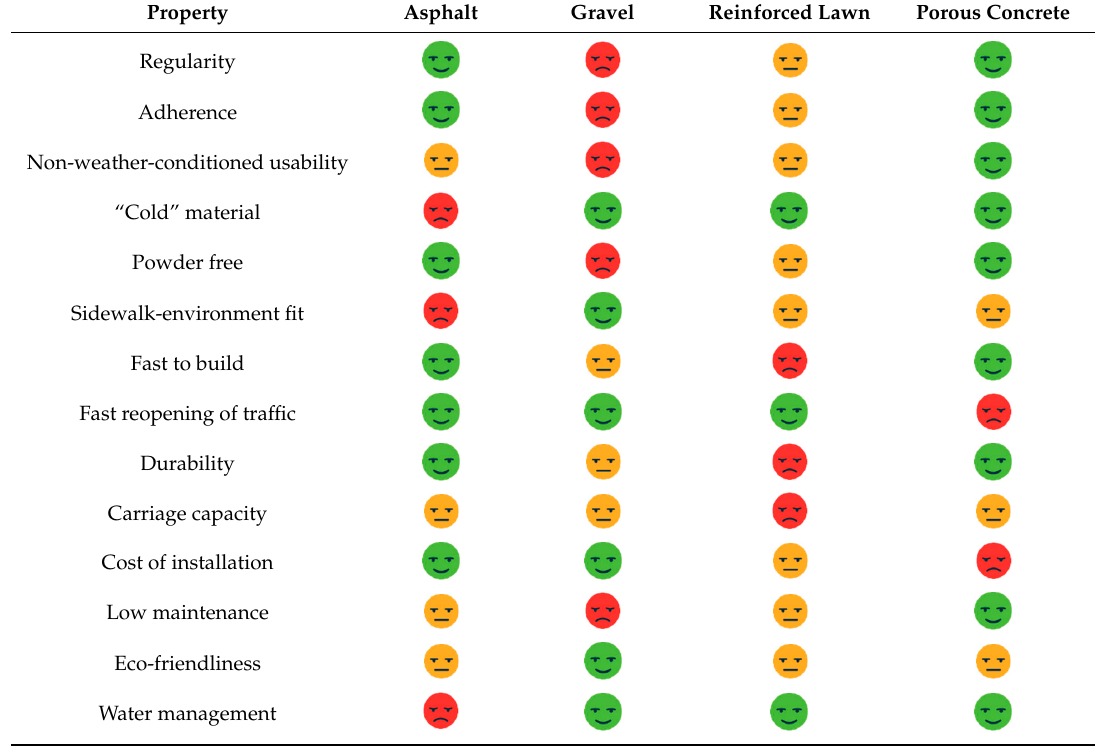
considered). with green, orange, and red symbols, respectively. All data refer to conventional performances of considered). Table 1. Structural, functional, and environmental performances of materials for pedestrian Table 1. Structural, functional, and environmental performances of materials for pedestrian Table 1. Structural, functional, and environmental performances of materials for pedestrian Table 1. Structural, functional, and environmental performances of materials for pedestrian each material (e.g., white asphalt, pervious concrete pavers, and concrete grid pavers are not with green, orange, and red symbols, respectively. All data refer to conventional performances of pavements. Green, orange, and red symbols represent good, fair, and poor performances, pavements. Green, orange, and red symbols represent good, fair, and poor performances, pavements. Green, orange, and red symbols represent good, fair, and poor performances, pavements. Green, orange, and red symbols represent good, fair, and poor performances, Table 1. Structural, functional, and environmental performances of materials for pedestrian pavements. considered). considered). Table 1. Structural, functional, and environmental performances of materials for pedestrian Table 1. Structural, functional, and environmental performances of materials for pedestrian Table 1. Structural, functional, and environmental performances of materials for pedestrian each material (e.g., white asphalt, pervious concrete pavers, and concrete grid pavers are not respectively. respectively. each material (e.g., white asphalt, pervious concrete pavers, and concrete grid pavers are not respectively. respectively. Table 1. Structural, functional, and environmental performances of materials for pedestrian Green, orange, and red symbols represent good, fair, and poor performances, respectively. pavements. Green, orange, and red symbols represent good, fair, and poor performances, pavements. Green, orange, and red symbols represent good, fair, and poor performances, pavements. Green, orange, and red symbols represent good, fair, and poor performances, pavements. Green, orange, and red symbols represent good, fair, and poor performances, considered). considered). 1. Structural, functional, and environmental performances of materials for pedestrian Table 1. Structural, functional, and environmental performances of materials for pedestrian Table 1. Structural, functional, and environmental performances of materials for pedestrian Table 1. Structural, functional, and environmental performances of materials for pedestrian respectively. respectively. each material (e.g., white asphalt, pervious concrete pavers, and concrete grid pavers are not respectively. respectively. Table pavements. Green, orange, and red symbols represent good, fair, and poor performances, pavements. Green, orange, and red symbols represent good, fair, and poor performances, pavements. Green, orange, and red symbols represent good, fair, and poor performances, pavements. Green, orange, and red symbols represent good, fair, and poor performances, considered). Table 1. Structural, functional, and environmental performances of materials for pedestrian Table 1. Structural, functional, and environmental performances of materials for pedestrian Table 1. Structural, functional, and environmental performances of materials for pedestrian Table 1. Structural, functional, and environmental performances of materials for pedestrian respectively. respectively. respectively. respectively. pavements. Green, orange, and red symbols represent good, fair, and poor performances, pavements. Green, orange, and red symbols represent good, fair, and poor performances, pavements. Green, orange, and red symbols represent good, fair, and poor performances, Table 1. Structural, functional, and environmental performances of materials for pedestrian Table 1. Structural, functional, and environmental performances of materials for pedestrian respectively. respectively. respectively. respectively. Table 1. Structural, functional, and environmental performances of materials for pedestrian pavements. Green, orange, and red symbols represent good, fair, and poor performances, pavements. Green, orange, and red symbols represent good, fair, and poor performances, pavements. Green, orange, and red symbols represent good, fair, and poor performances, Table 1. Structural, functional, and environmental performances of materials for pedestrian respectively. respectively. respectively. Table 1. Structural, functional, and environmental performances of materials for pedestrian pavements. Green, orange, and red symbols represent good, fair, and poor performances, pavements. Green, orange, and red symbols represent good, fair, and poor performances, Table 1. Structural, functional, and environmental performances of materials for pedestrian Table 1. Structural, functional, and environmental performances of materials for pedestrian respectively. Table 1. Structural, functional, and environmental performances of materials for pedestrian respectively. respectively. pavements. Green, orange, and red symbols represent good, fair, and poor performances, pavements. Green, orange, and red symbols represent good, fair, and poor performances, pavements. Green, orange, and red symbols represent good, fair, and poor performances, Table 1. Structural, functional, and environmental performances of materials for pedestrian Table 1. Structural, functional, and environmental performances of materials for pedestrian Table 1. Structural, functional, and environmental performances of materials for pedestrian respectively. respectively. respectively. Table 1. Structural, functional, and environmental performances of materials for pedestrian pavements. Green, orange, and red symbols represent good, fair, and poor performances, pavements. Green, orange, and red symbols represent good, fair, and poor performances, pavements. Green, orange, and red symbols represent good, fair, and poor performances, pavements. Green, orange, and red symbols represent good, fair, and poor performances, Table 1. Structural, functional, and environmental performances of materials for pedestrian respectively. Table 1. Structural, functional, and environmental performances of materials for pedestrian respectively. respectively. respectively. pavements. Green, orange, and red symbols represent good, fair, and poor performances, pavements. Green, orange, and red symbols represent good, fair, and poor performances, considered). Table 1. Structural, functional, and environmental performances of materials for pedestrian Table 1. Structural, functional, and environmental performances of materials for pedestrian Table 1. Structural, functional, and environmental performances of materials for pedestrian respectively. respectively. pavements. Green, orange, and red symbols represent good, fair, and poor performances, pavements. Green, orange, and red symbols represent good, fair, and poor performances, pavements. Green, orange, and red symbols represent good, fair, and poor performances, pavements. Green, orange, and red symbols represent good, fair, and poor performances, Table 1. Structural, functional, and environmental performances of materials for pedestrian Table 1. Structural, functional, and environmental performances of materials for pedestrian Table 1. Structural, functional, and environmental performances of materials for pedestrian Table 1. Structural, functional, and environmental performances of materials for pedestrian respectively. respectively. respectively. respectively. pavements. Green, orange, and red symbols represent good, fair, and poor performances, pavements. Green, orange, and red symbols represent good, fair, and poor performances, pavements. Green, orange, and red symbols represent good, fair, and poor performances, pavements. Green, orange, and red symbols represent good, fair, and poor performances, 1. Structural, functional, and environmental performances of materials for pedestrian Table 1. Structural, functional, and environmental performances of materials for pedestrian Table 1. Structural, functional, and environmental performances of materials for pedestrian Table 1. Structural, functional, and environmental performances of materials for pedestrian respectively. Table respectively. respectively. pavements. Green, orange, and red symbols represent good, fair, and poor performances, pavements. Green, orange, and red symbols represent good, fair, and poor performances, pavements. Green, orange, and red symbols represent good, fair, and poor performances, pavements. Green, orange, and red symbols represent good, fair, and poor performances, 1. Structural, functional, and environmental performances of materials for pedestrian Table 1. Structural, functional, and environmental performances of materials for pedestrian Table 1. Structural, functional, and environmental performances of materials for pedestrian respectively. respectively. respectively. respectively. Table pavements. Green, orange, and red symbols represent good, fair, and poor performances, pavements. Green, orange, and red symbols represent good, fair, and poor performances, pavements. Green, orange, and red symbols represent good, fair, and poor performances, Table 1. Structural, functional, and environmental performances of materials for pedestrian respectively. respectively. Table 1. Structural, functional, and environmental performances of materials for pedestrian Table 1. Structural, functional, and environmental performances of materials for pedestrian respectively. pavements. Green, orange, and red symbols represent good, fair, and poor performances, pavements. Green, orange, and red symbols represent good, fair, and poor performances, respectively.